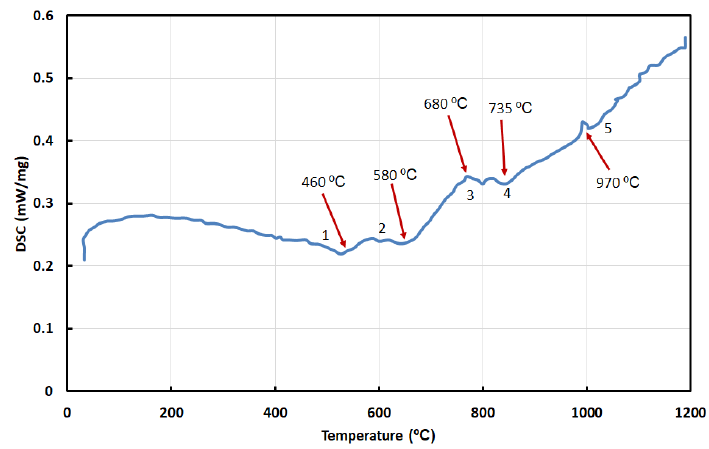
Figure 2. DSC curve of maraging steel of